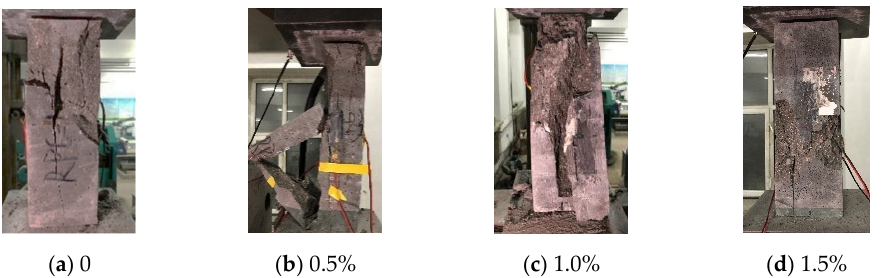
Figure 9. Compression failure modes of prismatic specimens with different fiber contents at normal temperature.